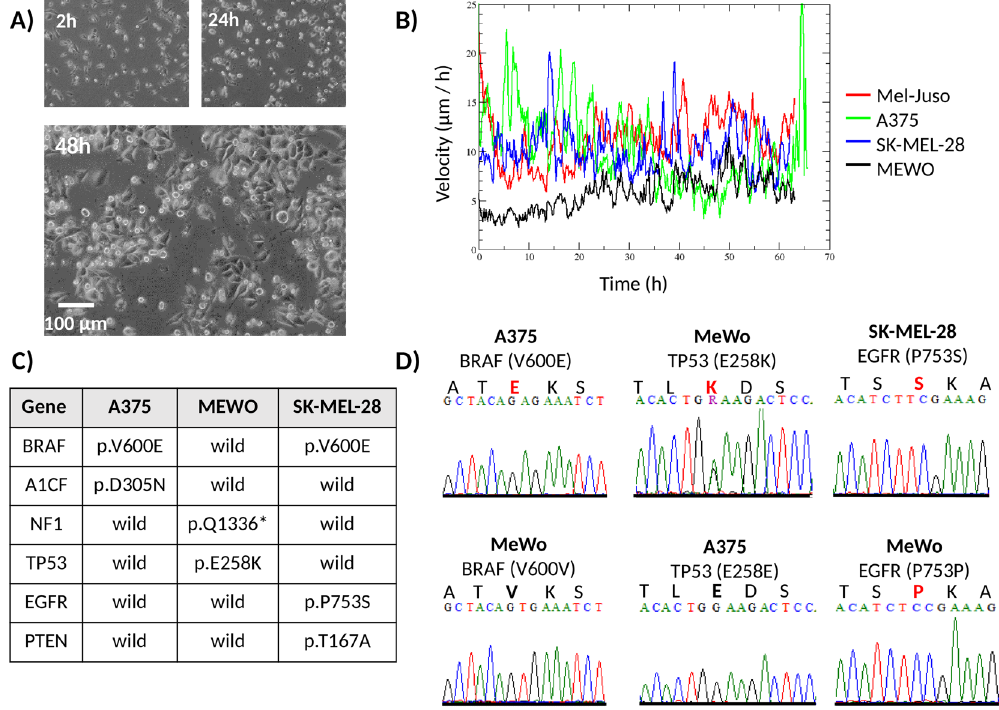
Figure 2. Migration of different cell lines. Video microscopy images of the highly active A375 ( A ). One can compute the absolute movement as a function of time and use this to compute cell line velocities ( B ). Selected key mutations for NGS sequencing ( C ) and mutations validated using Sanger sequencing ( D